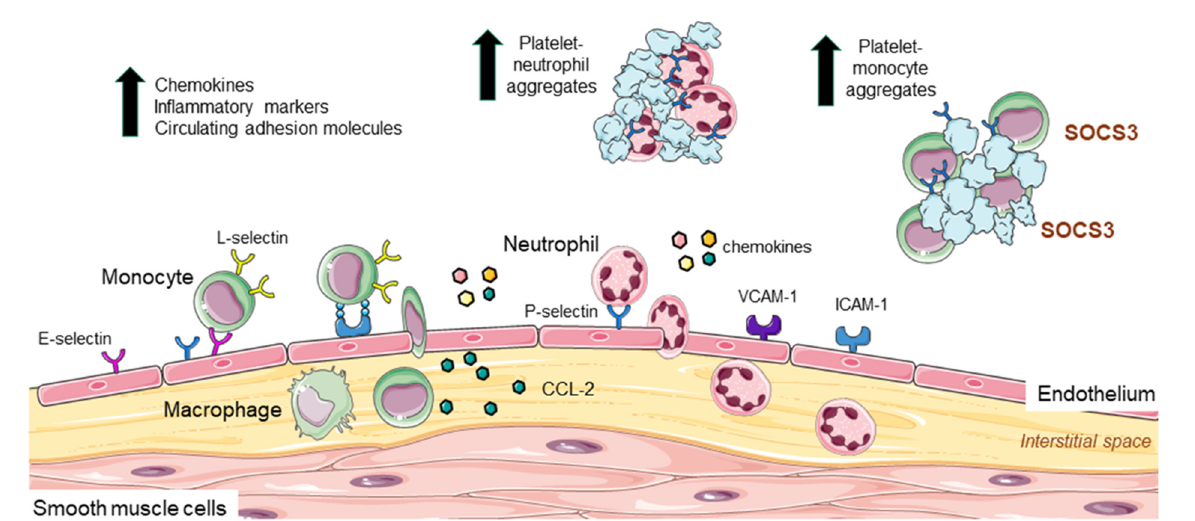
FIGURE1 Leukocyte and platelet adhesion, recruitment to the endothelium, and contribution to inflammation in PAD. In atherosclerosis increased inflammation upregulates the expression of VCAM-1 and ICAM-1 as well as E- and P- selectin on endothelial cells. These adhesion markers are involved in the process of leukocyte recruitment (rolling, activation, and adhesion to the endothelium), with L-selectin also implicated in adhesive interactions between leukocytes and endothelial cells. Once adhered, leukocytes migrate into the interstitial space toward a chemotactic mediator such as CCL-2. Here, monocytes differentiate into macrophages. Monocytes are independently associated with PAD and increased neutrophil: lymphocyte ratio is linked to PAD severity. Circulating chemokines, inflammatory markers (e.g., CRP, interleukins, and matrix metalloproteinases), and adhesion molecules (ICAM and P-selectin) are up regulated in PAD and associated with disease severity. Platelets also secrete molecules that support platelet-neutrophil and platelet-monocyte interaction and adhesion. Circulating platelet-leukocyte interactions are considered a biomarker for